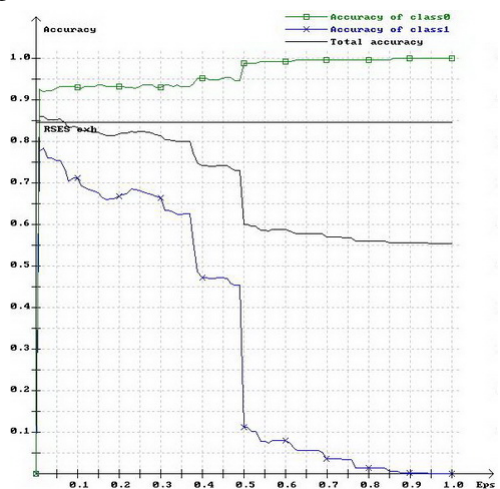
Fig. 7. Results for algorithm 5 v2, Best result for ε = 0 . 02: accuracy = 0.86087, coverage = 1